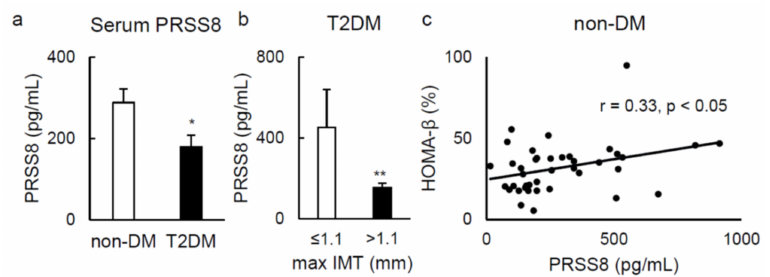
Figure 7. Serum PRSS8 levels was negatively associated with the presence of type 2 diabetes and in- creased intima media thickness. ( a ) The ELISA of human PRSS8 levels in the serum of the nondiabetes mellitus (non-DM) and type 2 diabetes mellitus (T2DM) participants (n = 39–40 per group). Values are shown as the mean ± SEM; * p -value < 0.05 ( t test). ( b ) The maximum intima media thickness (max IMT) measured by carotid ultrasonography in T2DM. Values are shown as the mean ± SEM; ** p -value < 0.01 ( t test). ( c ) Homeostatic model assessment beta cell function (HOMA- β ) in non-DM was shown (Pearson product-moment correlation